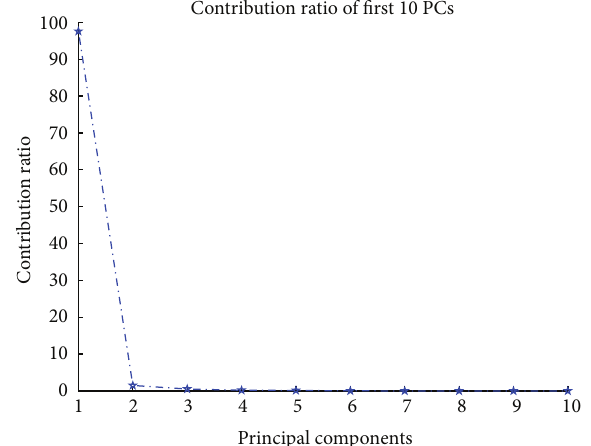
Figure 8: Contribution ratio of first 10 principal components